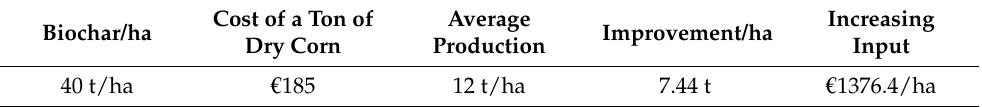
Table 6. Main variables in the application of biochar in corn.